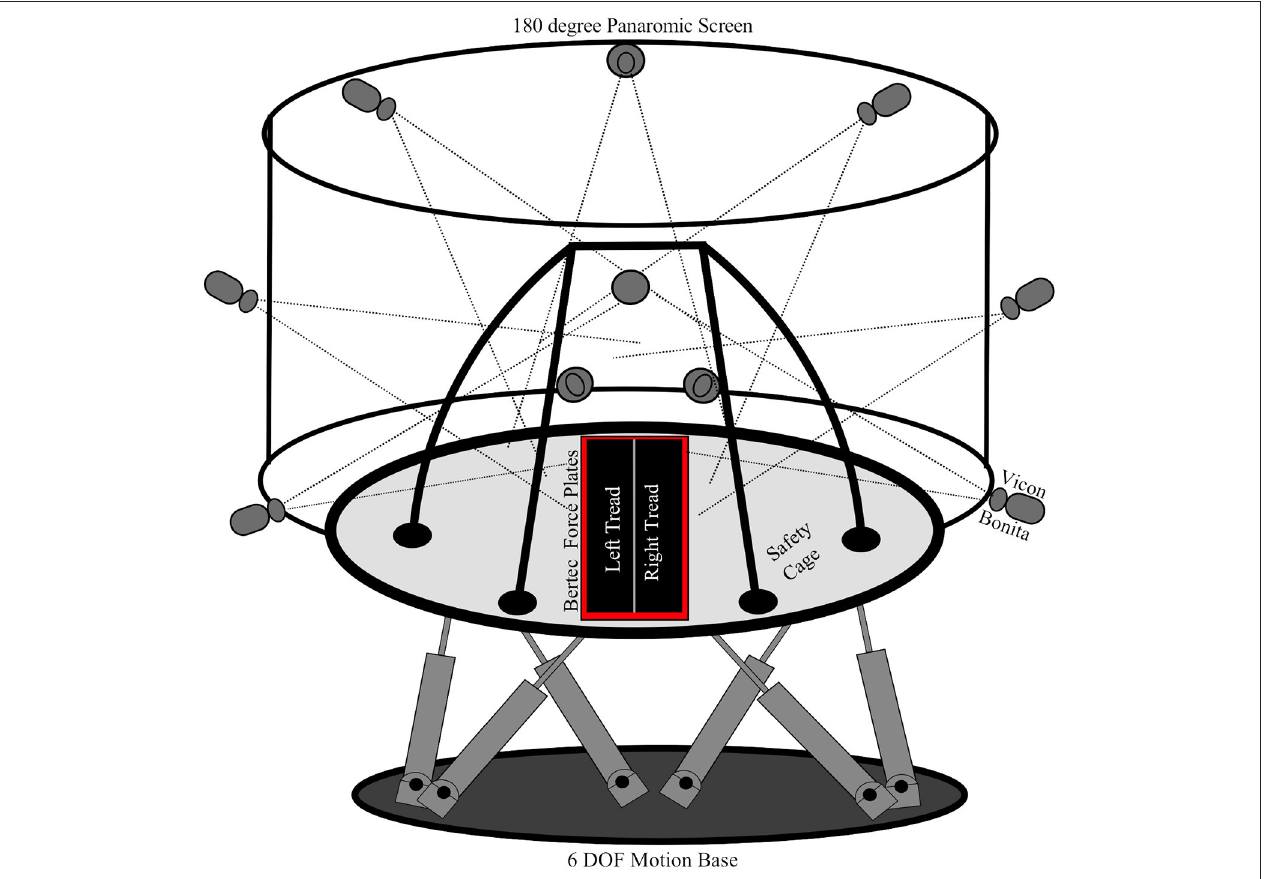
FIGURE 1 | The computer assisted rehabilitation environment (CAREN) was used to collect the datasets for this research. The CAREN is equipped with a 10 Vicon Bonita infrared motion capture system, Bertec continuous force plates, split belt treadmill, 6 degree of freedom motion platform, and a fully enclosed safety cage. The subjects are secured to the safety cage of the CAREN for their safety.